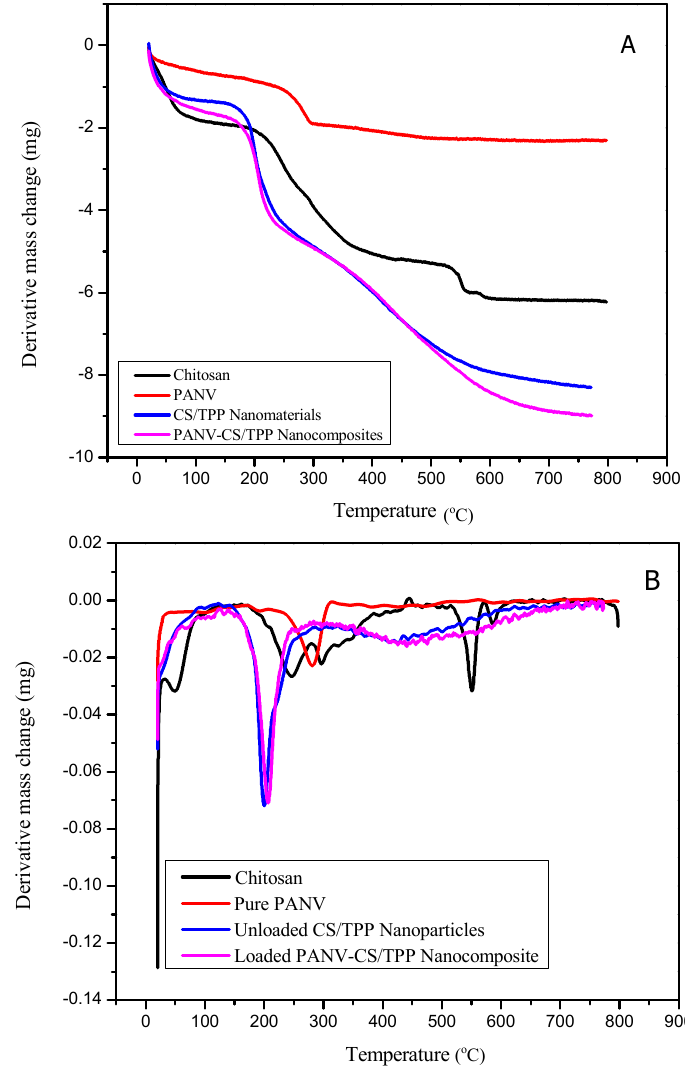
Figure 6. ( A ) Simultaneous thermal analysis (STA) curves of chitosan, PANV, free CS/TPP nanomaterials and PANV-CS/TPP nanocomposites; ( B ) Differential thermal gravimetric (DTG) curves of chitosan, PANV, free CS/TPP nanomaterials and PANV-CS/TPP nanocomposites.